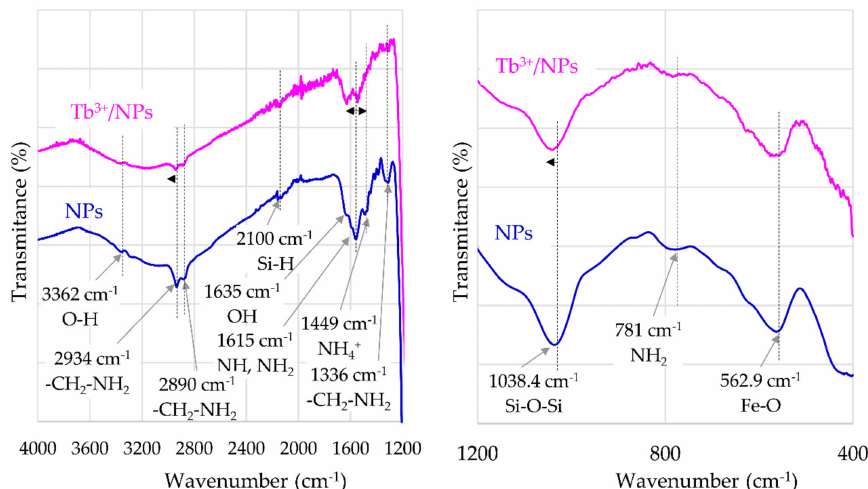
Figure 3. FT-IR spectra for γ -Fe 2 O 3 -NH 4 OH@SiO 2 (APTMS) NPs and Tb 3 + / γ -Fe 2 O 3 -NH 4 OH@SiO 2 (APTMS)